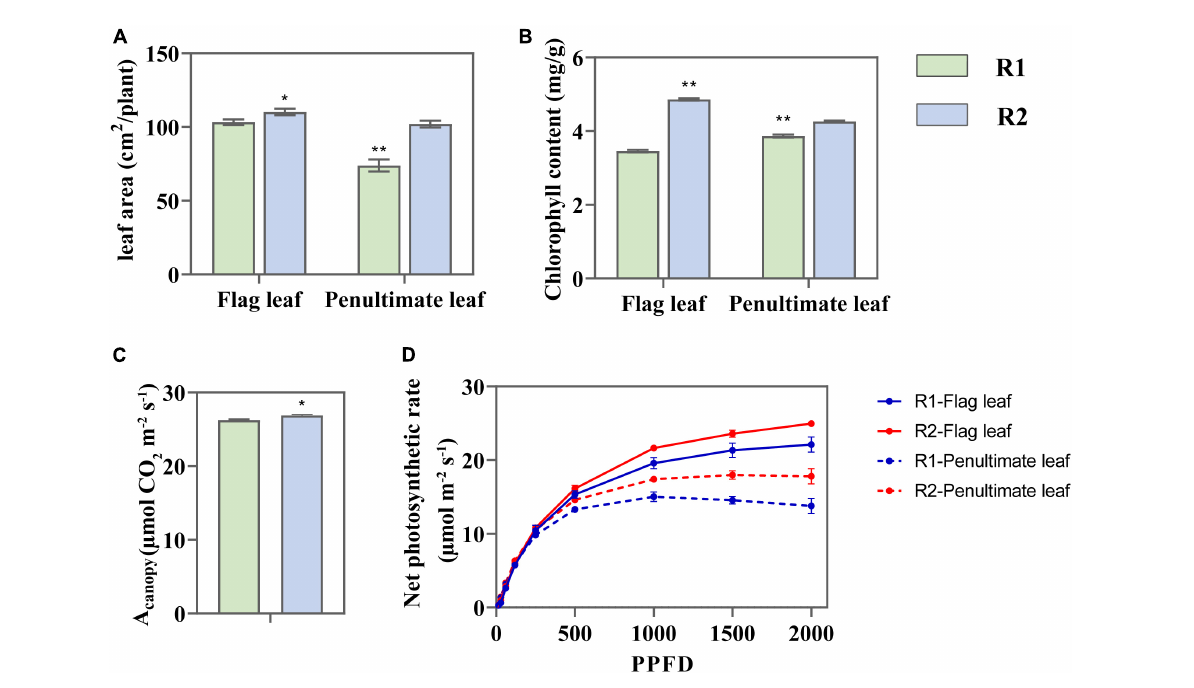
FIGURE3 Change in leaf area (A) , chlorophyll content (B) , canopy photosynthetic rate (A canopy ) (C) , light response curve (LRCs) (D) of flag and penultimate leaves at anthesis under different row spacing treatments. Results expressed as mean ± standard deviations (SD); Error bars represent SD. Significant differences marked by asterisks (* p < 0.05; ** p <